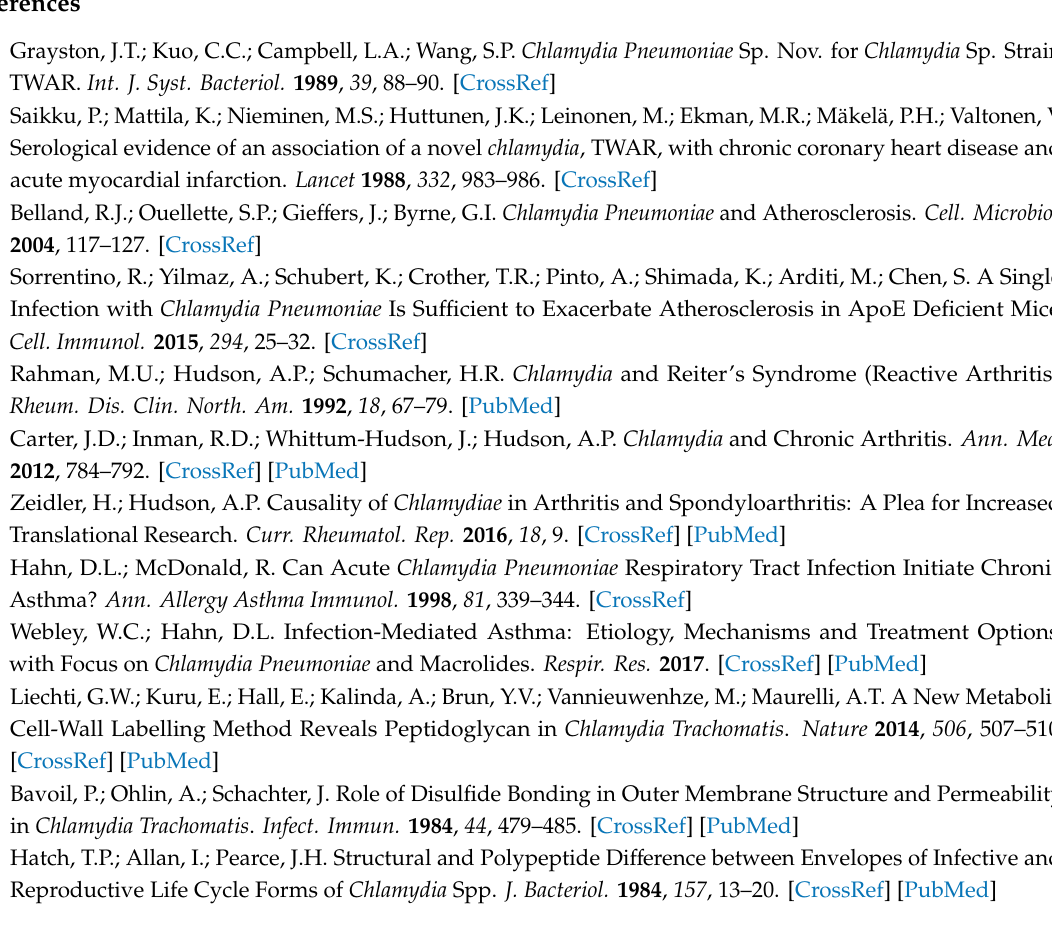
Figure S1: Localisation precision histograms corresponding to dSTORM data from Figure 3. Table S1: Primers used for cysteine mutant